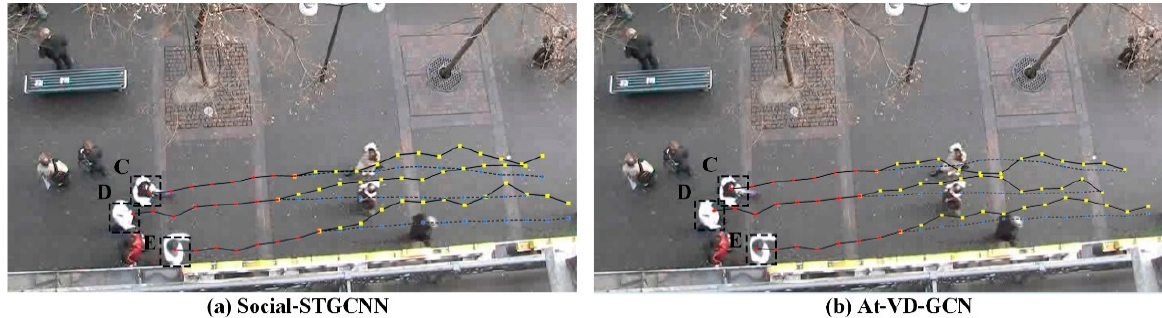
Figure 10. Comparison of the trajectory prediction of the model in this paper with that of Social- STGCNN in multi-pedestrians gathering interaction.